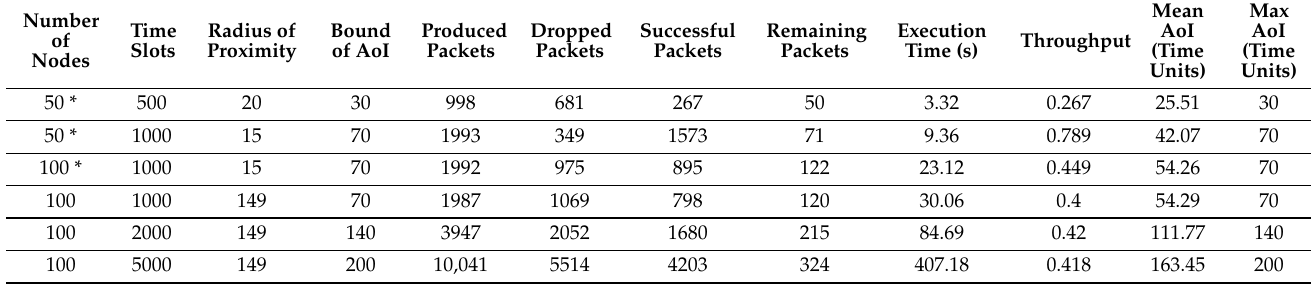
Table 4. Initial results for